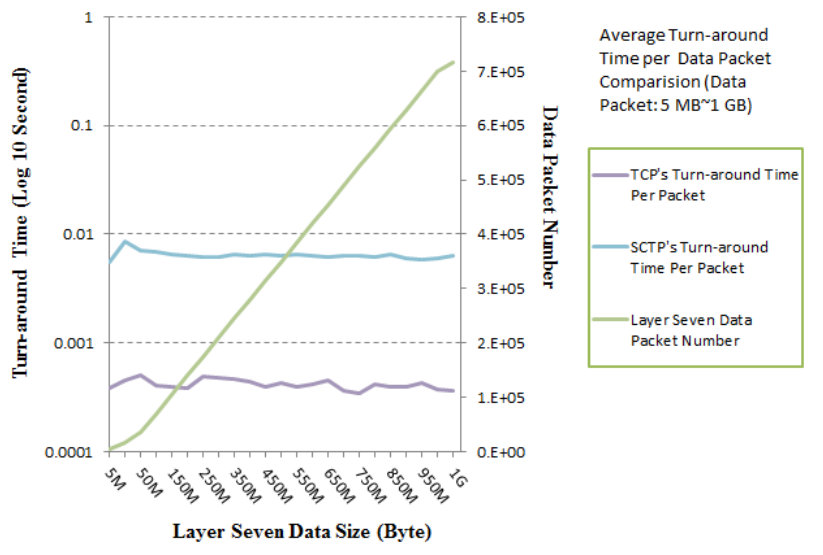
Figure 11. Turn-around time per packet comparison between TCP and SCTP-Tunnel for various data packet numbers: 5 MB–1